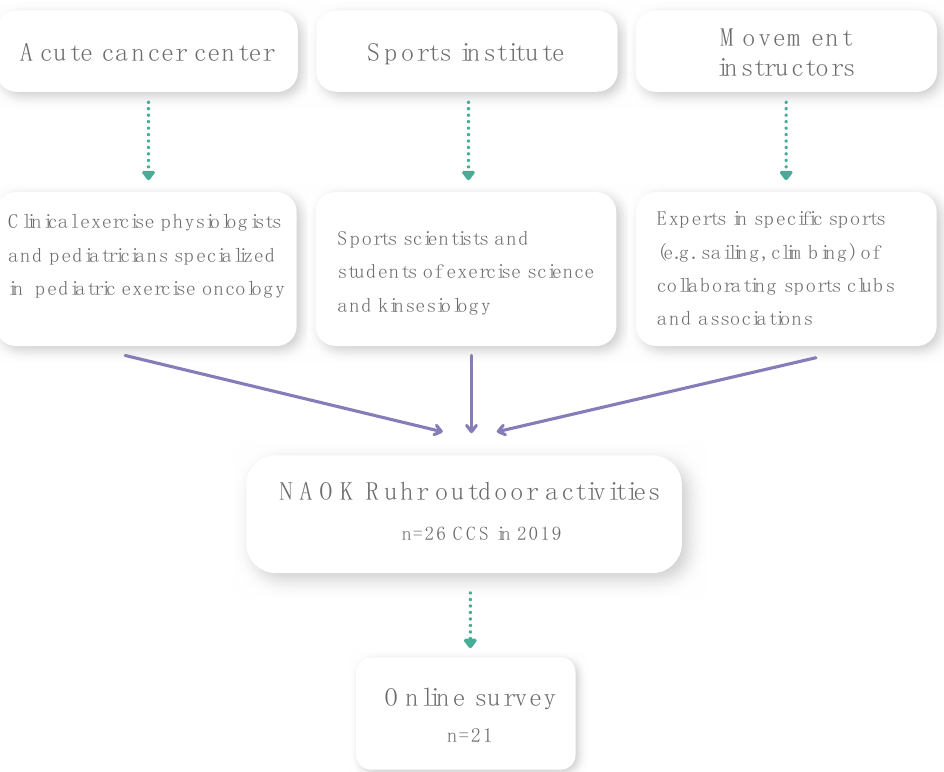
Figure 1. Illustration of the program in the NAOK Ruhr and participation of childhood cancer survivors (CCS) in activities in 2019 and the online survey.